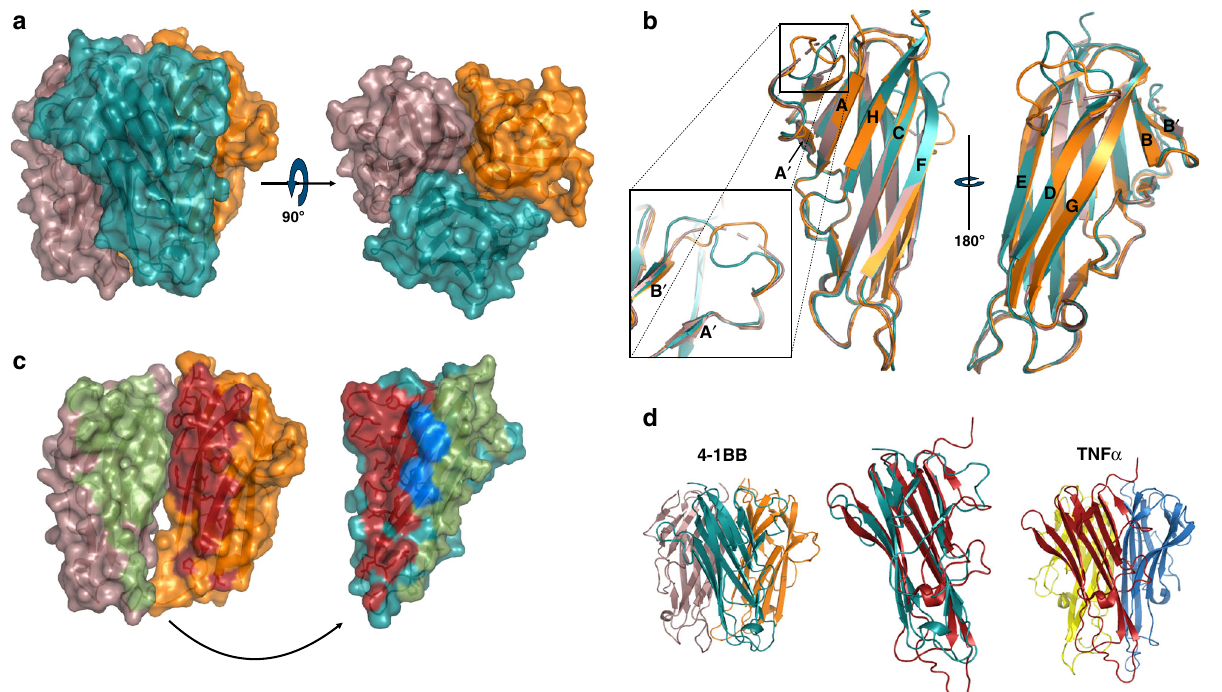
Fig. 3 Structure of 4-1BBL. a Surface representation of assembled trimer seen from the side. A 90° rotation shows the threefold axis down the center of the trimer. b Superposition of all three ligand protomers in the asymmetric unit. Individual strands identi fi ed by black letters. Variability between protomers in DE loop seen in the outer beta sheet (right). Inset shows variability of loop A ′ B ′ between ligand protomers. Ligand protomers shown in surface representation and colored orange, deep teal, and dirty violet for chains A, B, and C, respectively. c Open book view of the interfaces between ligand protomers. Interface between chain B and chain A highlighted in fi rebrick red. Interface between chain B and chain C highlighted in smudge green. Residues on chain B participating in both interfaces highlighted in marine. d Comparison of 4-1BBL (left panel) with TNF α (right panel, PDB code: 1TNF). Superposition of ligand protomers from 4-1BBL (teal) and TNF α